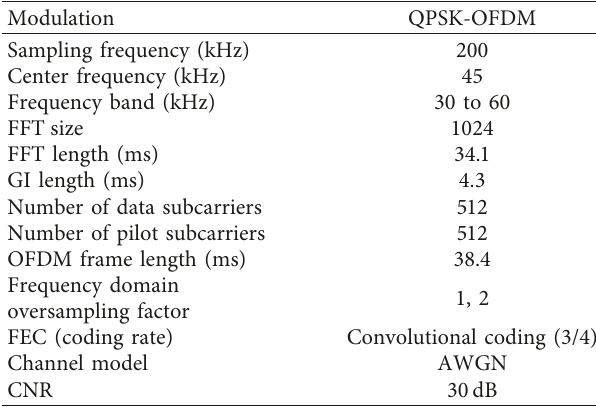
Figure 3: OFDM model with Doppler shift. Table 1: OFDM